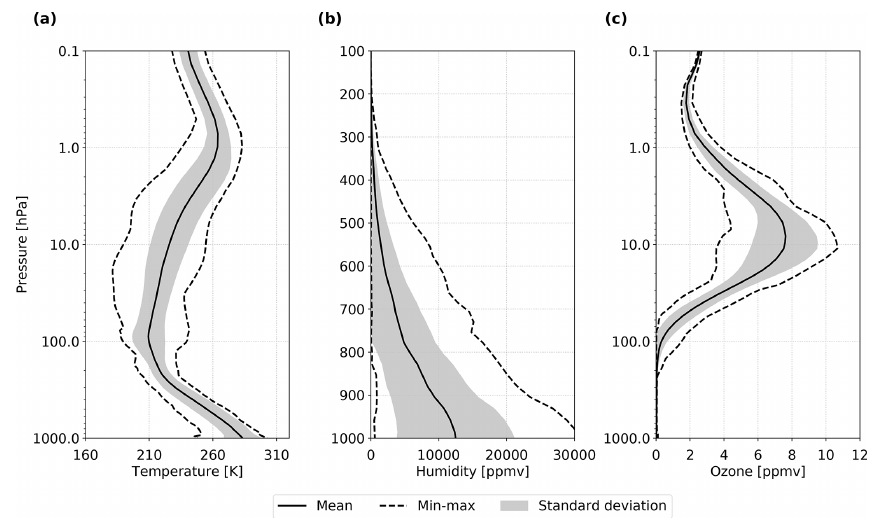
Figure 2. Mean ± standard deviation and min–max values of temperature (a) , humidity (b) and ozone (c) profile with respect to pressure over the subset of the 60 atmospheric profiles. Note that humidity statistics are shown between 1000 and 100hPa. Table 1. Table of IASI spectrum specifications for bands 1 (645 to 1210cm − 1 ) and 2 (1210 to 2019.75cm − 1